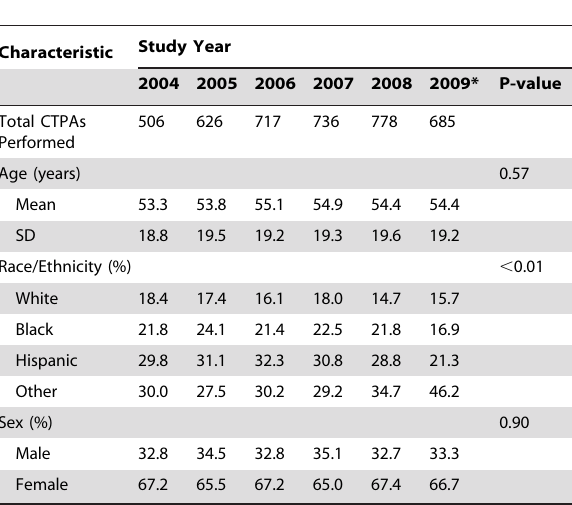
Table 1. Demographic data for subjects who underwent a CTPA in the ED.